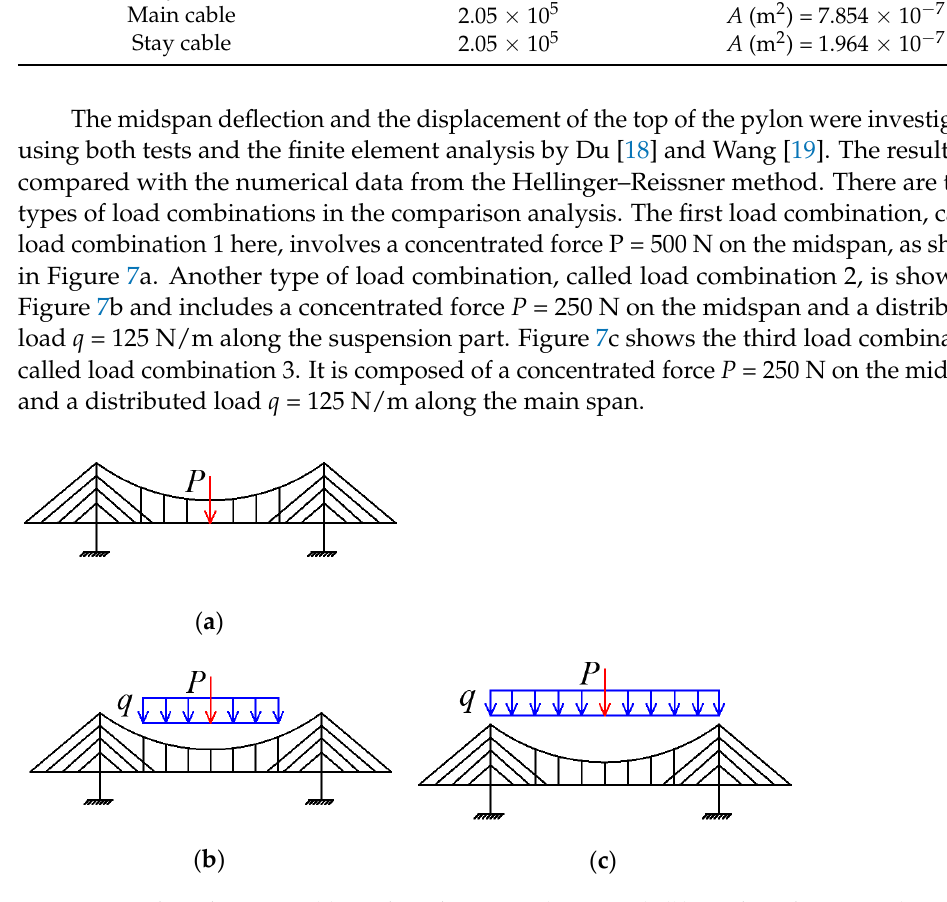
Table 1. Material properties.